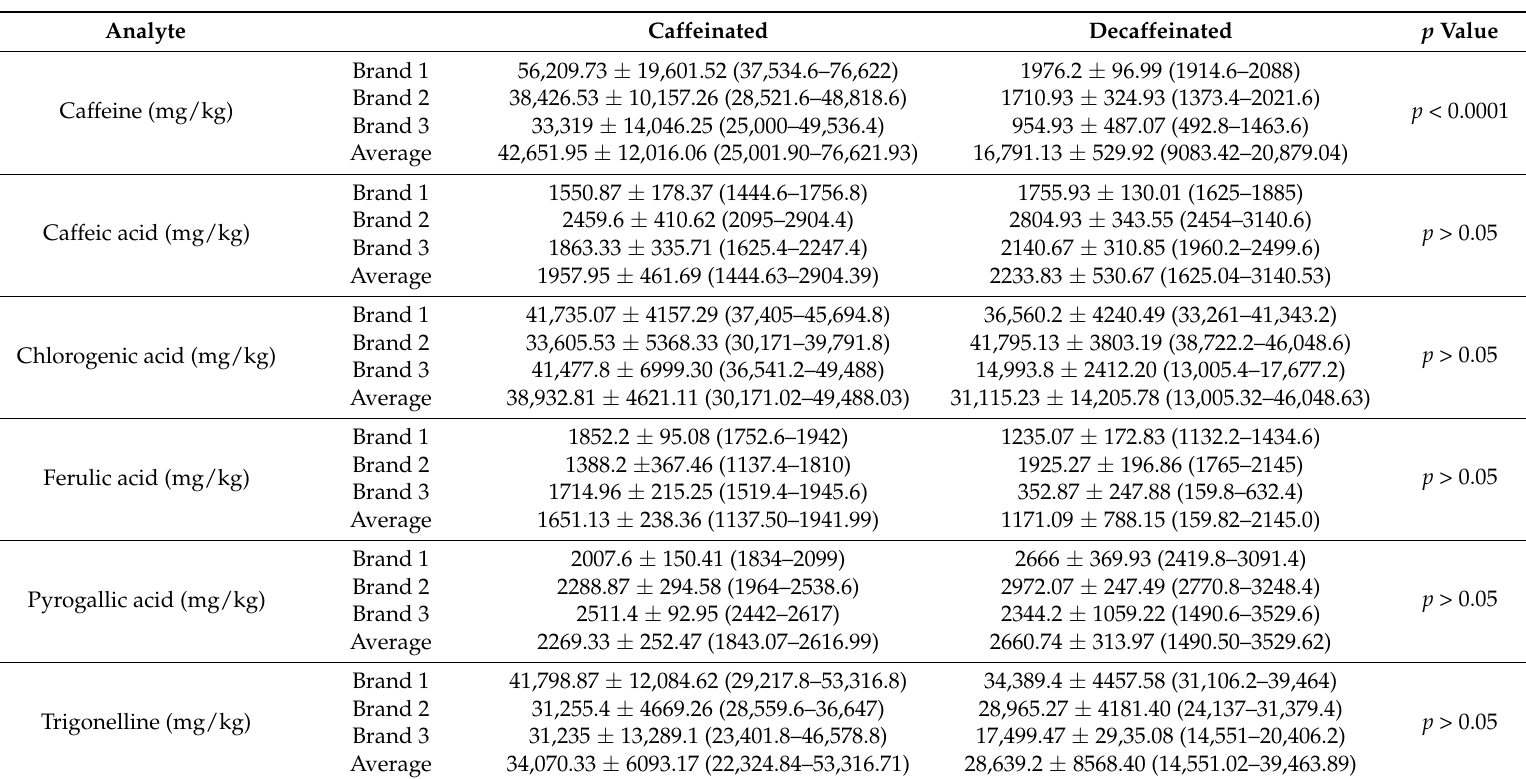
Table 2. Summary of the average ± SD (min-max) quantity in mg/kg of each of the analytes of interest in caffeinated and decaffeinated